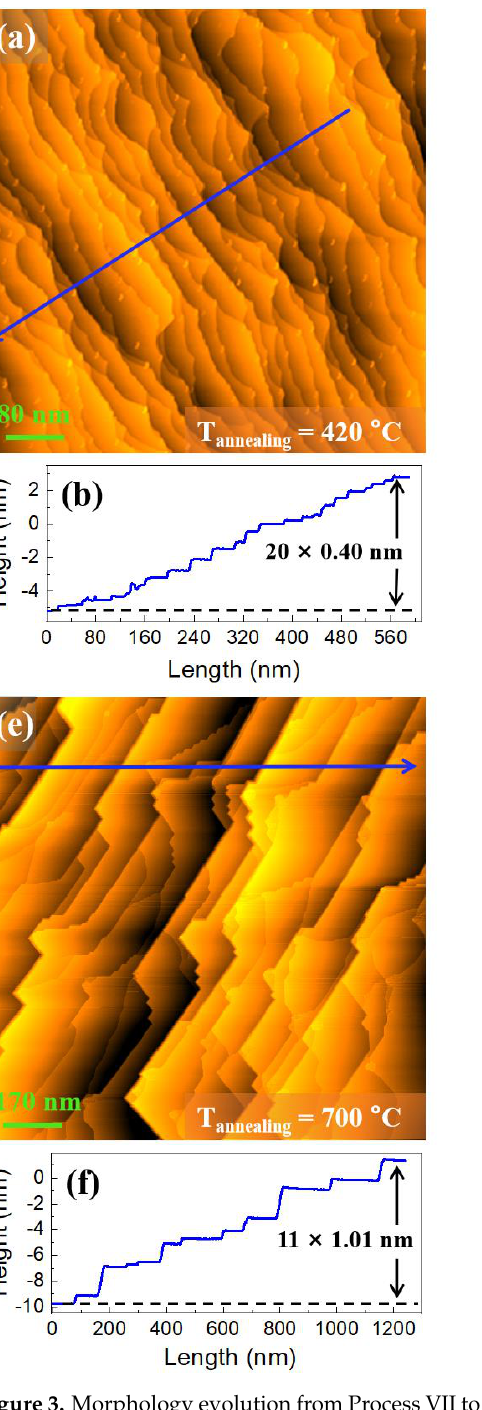
Figure 3. Morphology evolution from Process VII to Process X. ( a , c , e , g ) STM images from the samples after annealing at 420 °C, 420 °C, 700 °C, and 760 °C, respectively; ( b , d , f , h ) the height profiles along the blue arrows in ( a , c , e , g ), respectively. The black arrows indicate the screw dislocations. Here, the scanning bias voltage and current in images ( a , b ) are equal to 1 V and 0.1 nA, and in images ( e , g ) are equal to 2 V and 0.1 nA, respectively.